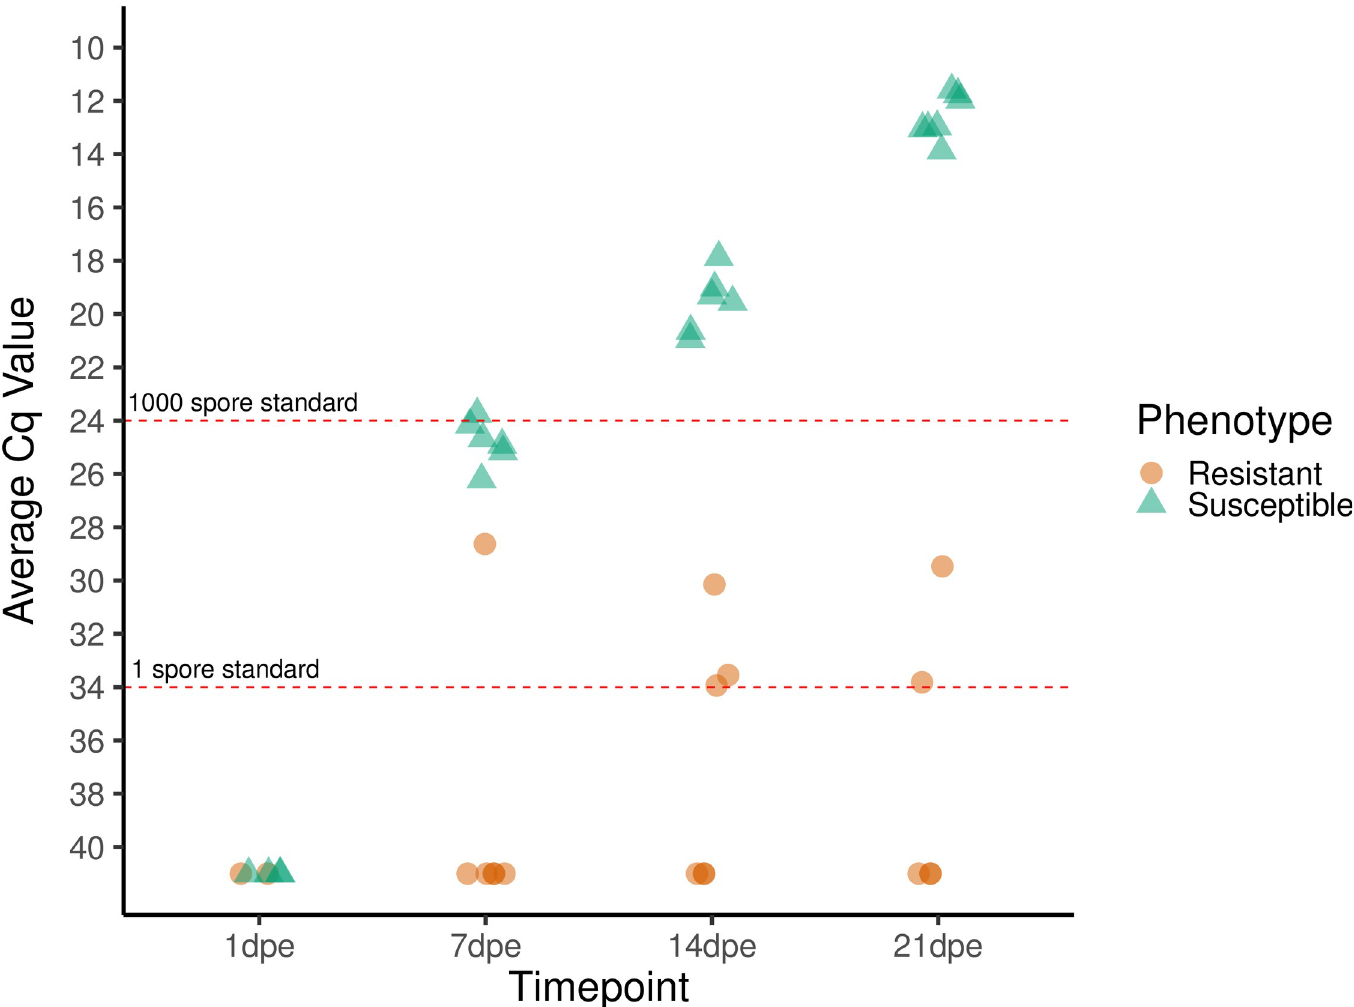
Fig 3. Relative quantity of Ceratonova shasta DNA present in the gills (1 dpe) and intestine (7, 14, and 21 dpe) of infected steelhead ( Oncorhynchus mykiss ). Each symbol represents the average quantitative cycle (Cq) of 100 ng of DNA extracted from the whole tissue (gills or intestine) of one fish that was assayed in triplicate by qPCR. Six fish of each phenotype were assayed at each timepoint. Fish that tested negative were assigned a nominal Cq value of 41. Dashed red lines indicate the average Cq values obtained from 1 and 1000 actinospore standards.